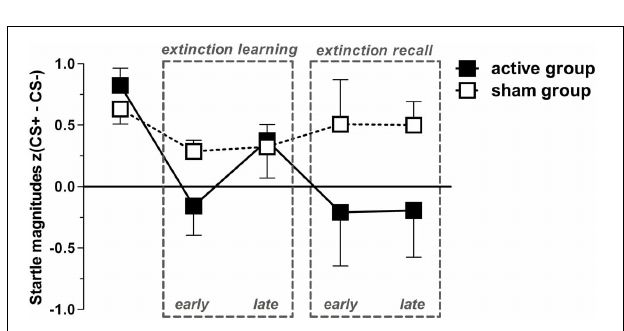
FIGURE 4 | Conditioned responses ( CS + minus CS − ) for both groups indexed by Fear-potentiated startle magnitudes (mean + SEM). The active group exhibit a significant linear trend through both extinction phases indicated by a proportionately CR decrement from fear acquisition (first data point) throughout both extinction phases. For the active group, all dependent t -tests ( p one − tailed < 0 . 05) for acquisition with each extinction phase showed significant results, except for acquisition vs. late extinction day 1 which revealed only a trend-wise significant p -value ( p < 0 . 1). For the sham group, only the early extinction day 1 compared to the acquisition phase revealed a significant difference thereby indicating extinction learning; all other scores resemble the acquisition phase ( p > 0 .